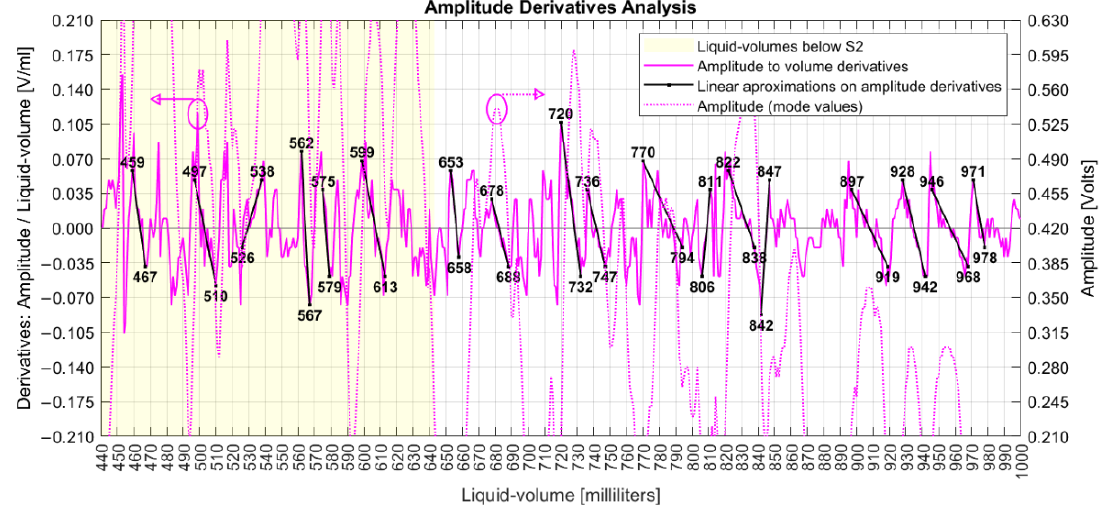
Figure 15. Liquid volumes with linear intervals on the derivative of amplitude series.